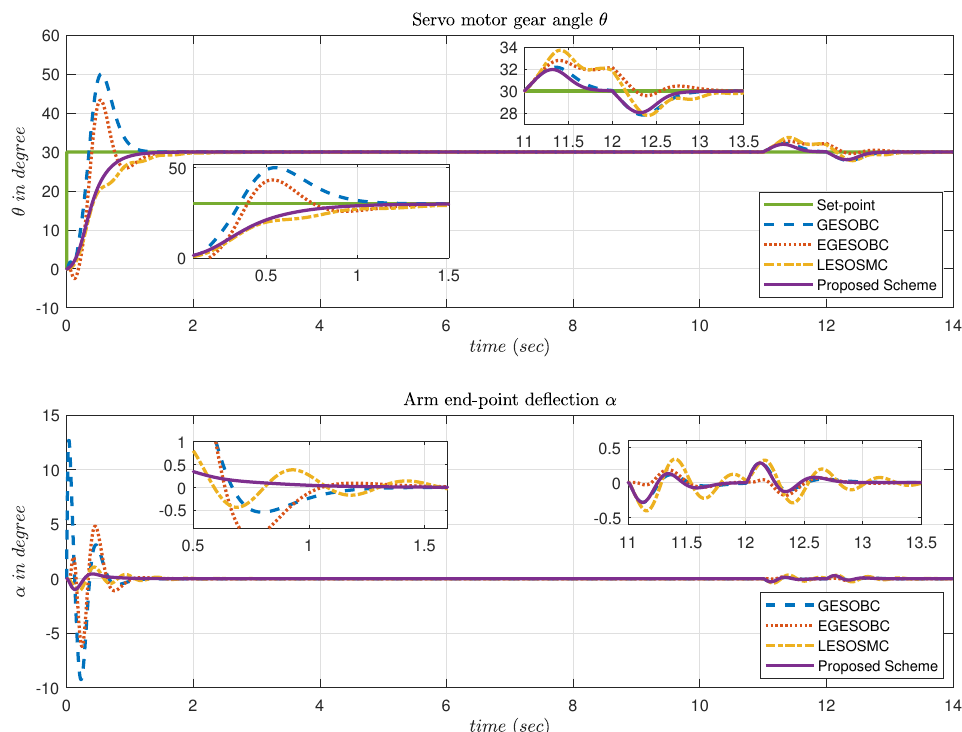
Figure 10. Simulation result of output tracking θ and arm end-point deflection α .